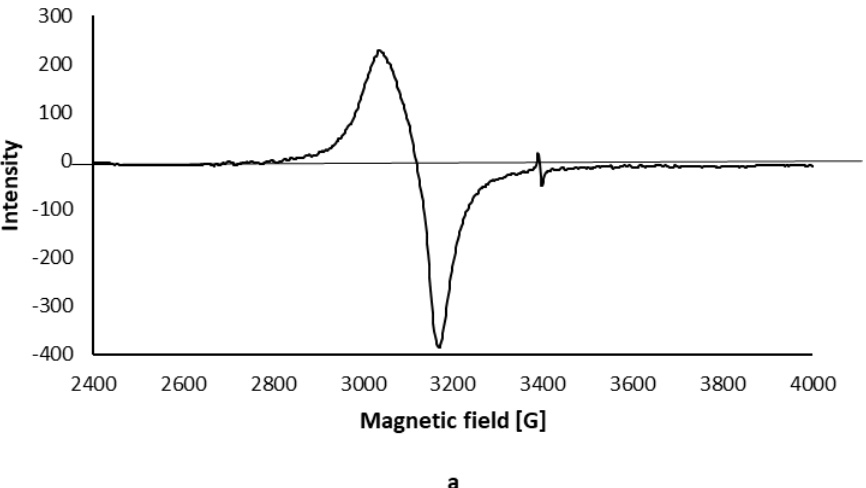
Table 4. Thermodynamic data for treated with GP deionized water saturated with